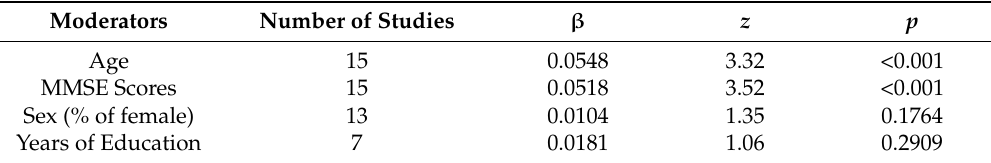
Figure 2. Meta-analysis of serum BDNF levels between AD, MCI, and healthy controls (HC). ( A ) Forest plots depicting the standardized mean differences of serum BDNF levels of patients with AD compared to healthy controls; ( B ) Forest plots depicting the standardized mean differences of serum BDNF levels of individuals with MCI compared to AD; ( C ) Forest plots depicting the standardized mean differences of serum BDNF levels of individuals with healthy controls compared to MCI. Table 3. Results of meta-regression for serum BDNF levels for patients with AD compared to healthy controls.